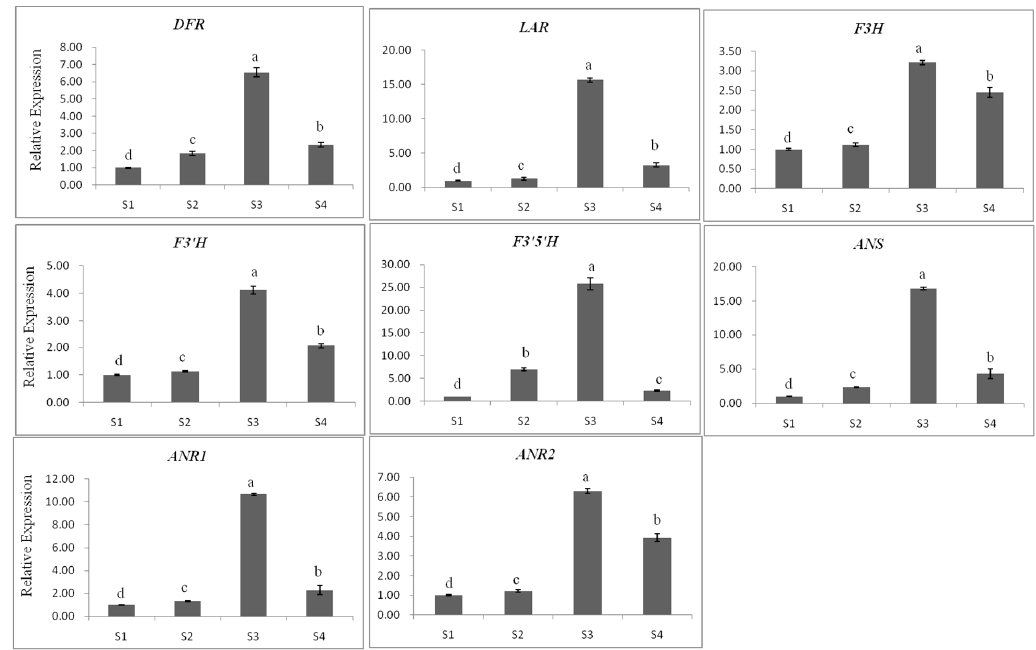
Figure 6. Expression levels of CsF3 ’ H & other flavan 3-ol biosynthesis related genes for tea seedling at different stages. The data represent the mean ± SD from three independent measurements. Means in each column for each genes labeled with the same letter are not significantly different ( p > 0.05) based on one-way ANOVA with Duncan’s multiple range test.